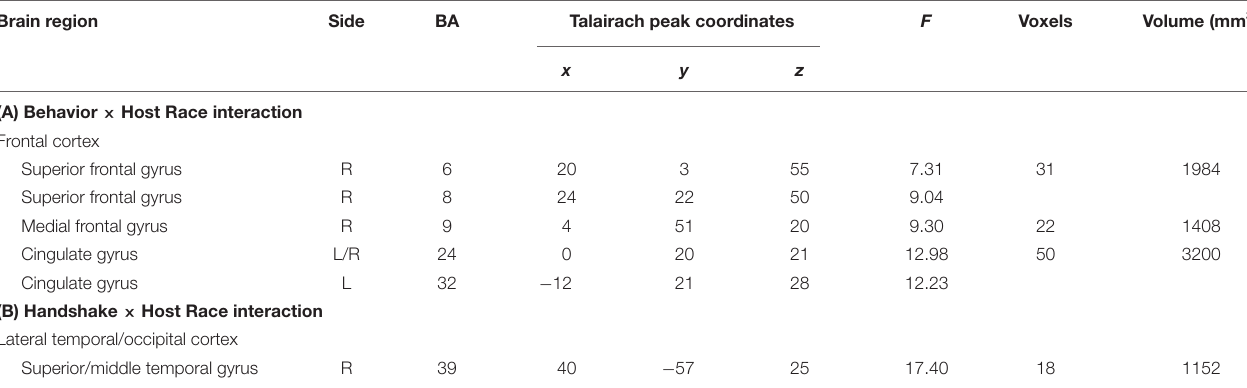
TABLE 2 | Brain regions showing significant interaction effects of behavior/handshake and host race linked to observation of social encounters with ingroup and outgroup hosts. Brain region Side BA Talairach peak coordinates